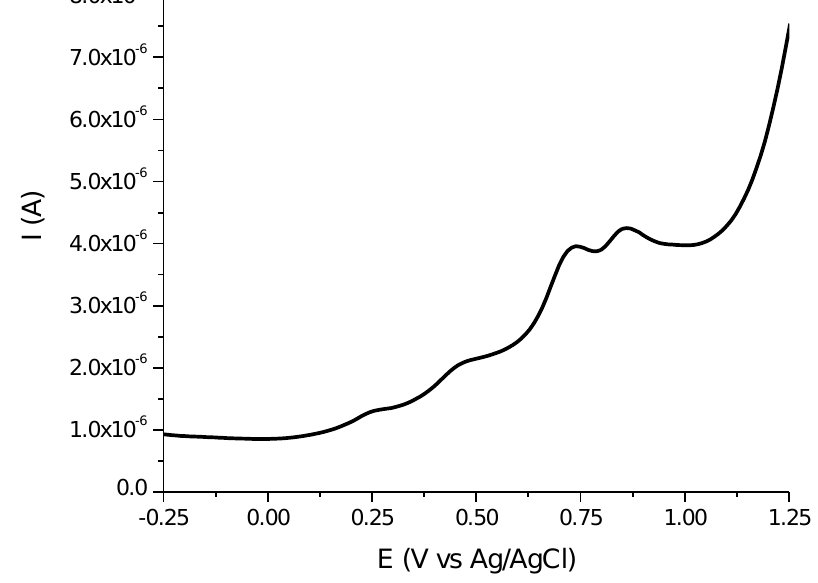
Figure 2. Differential pulse voltammogram of the SM extract (1 mg/mL).